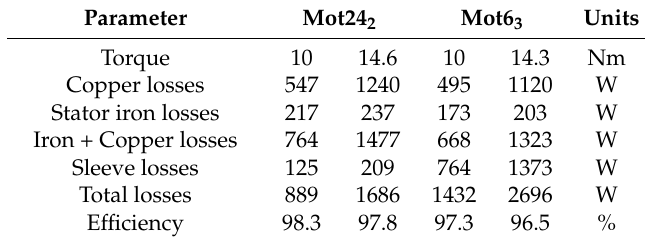
Table 3. Losses and efficiency of the selected optimized machines at rated and overloaded conditions.